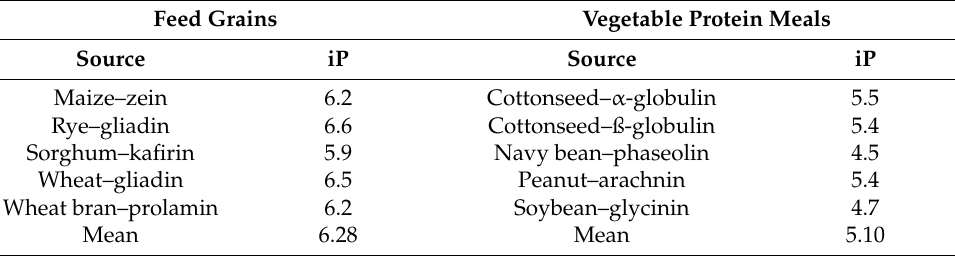
Table 2. The isoelectric point (iP) of various proteins: selected from Csonka et al. [59]. Feed Grains Vegetable Protein